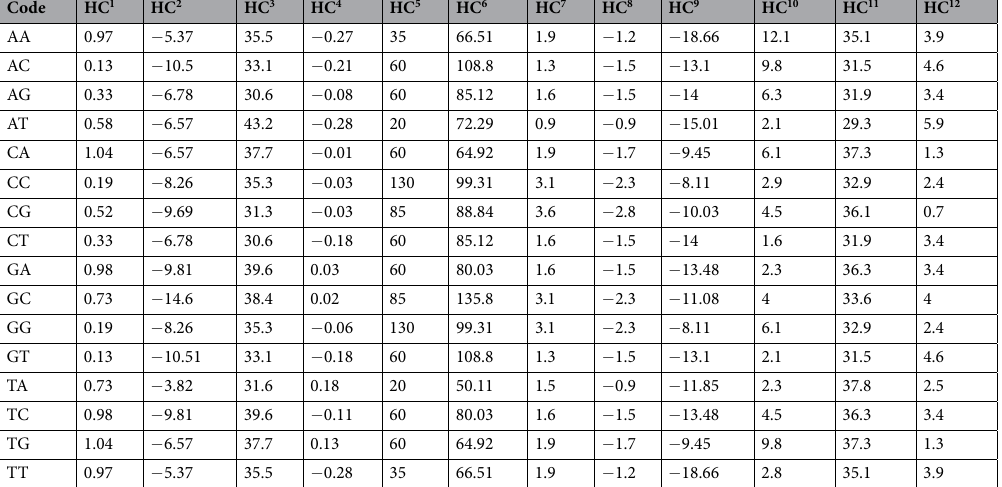
Table 7. The original values of the twelve PC properties for each